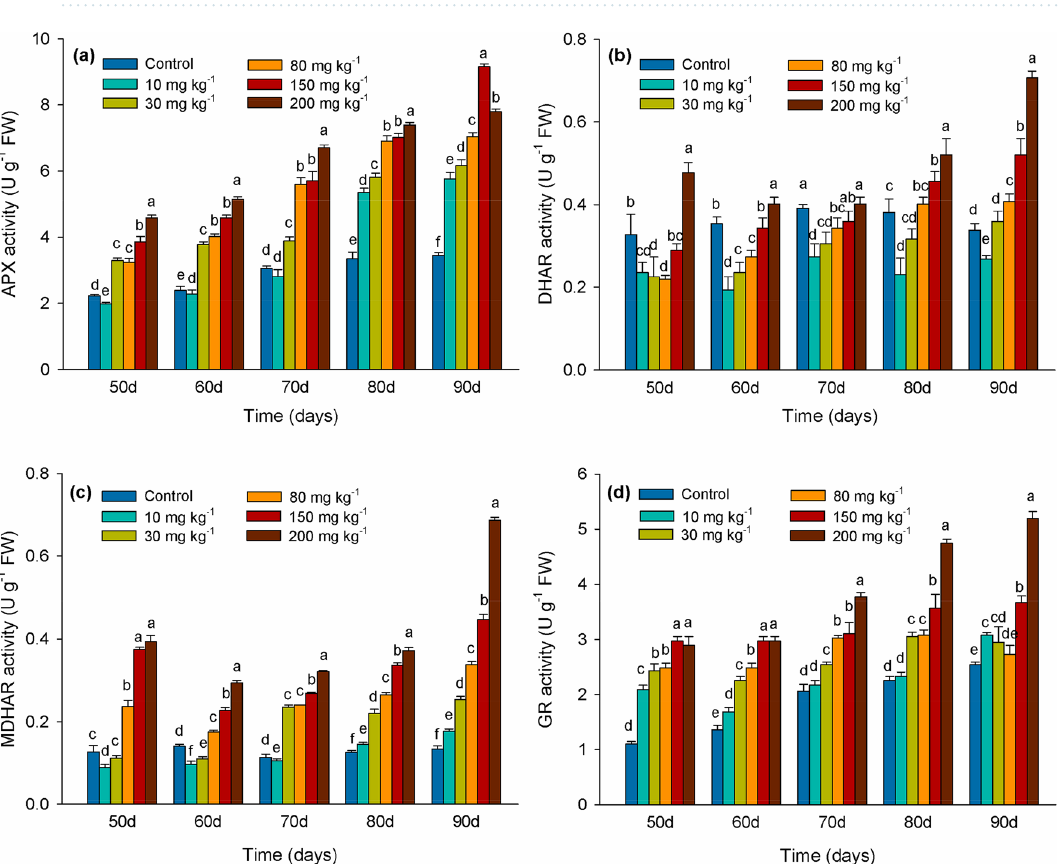
Figure 2. APX (ascorbate peroxidase) ( a ), DHAR (dehydroascorbate reductase) ( b ), MDHAR (monodehydroascorbate reductase) ( c ) and GR (glutathione reductase) ( d ) activities in leaves of Lonicera japonica Thunb. cuttings exposed to different concentrations of Cd. Different letters indicate a significant difference ( P < 0.05) based on Duncan’s multiple range test at 5% level. Values are the mean ± SD (n =